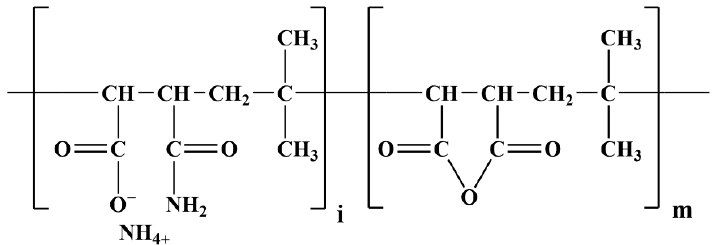
Figure 1. The chemical structure of IBMA.